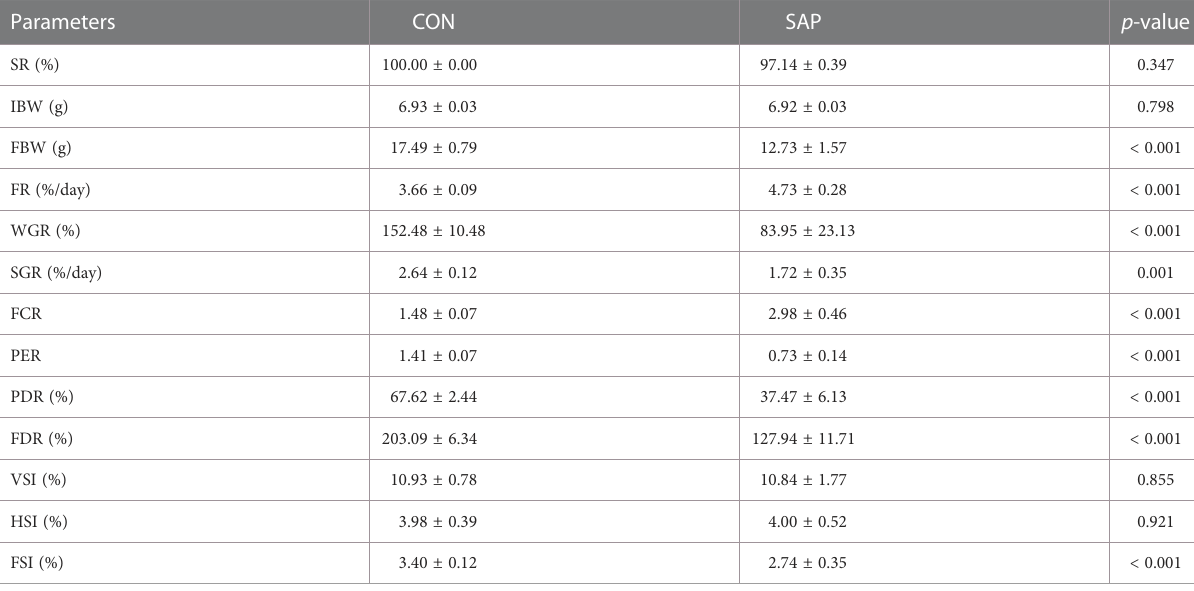
TABLE 2 Effects of dietary soybean saponin Bb on growth performance and morphology of juvenile P. sinensis ( n = 5 for growth performance, n = 8 for morphological parameters).